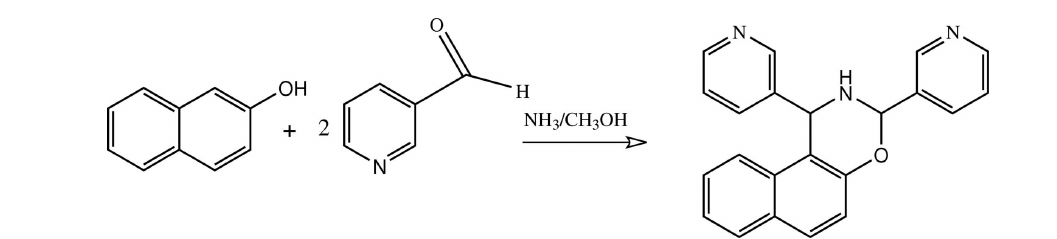
Figure 2 The crystal packing diagram of the title compound showing the infinite zigzag chain along the b axis, formed through N —H···N hydrogen bonding (dashed lines) [Symmetry codes: (*) 1 - x ,1/2 + y ,1/2 - z ].